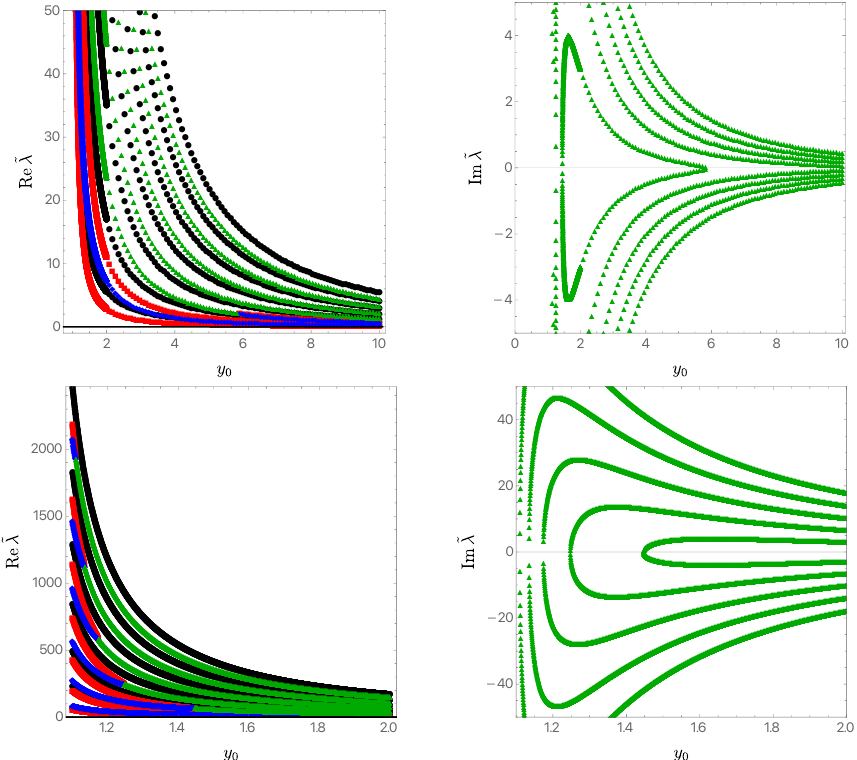
Figure 5 . The real part (left column) and the imaginary part (right column) of the excited modes as a function of y 0 for y 0. The bottom row is a zoom of the top row and all plots have d “ 5. ` “ The colour coding is as follows: green triangles are non-gauge modes with complex eigenvalues; blue diamonds are non-gauge modes with negative norm under ˆ G ; red squares are non-gauge modes with positive norm under ˆ G and the black disks are pure gauge modes. Each green triangle has a